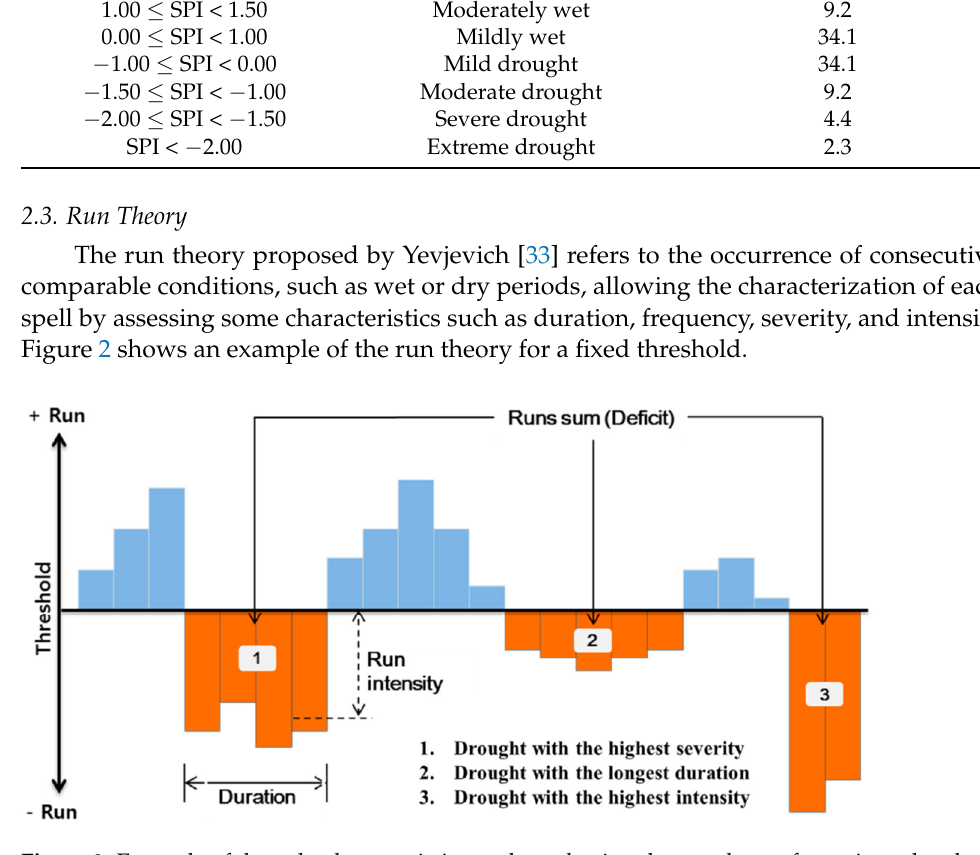
Figure 2. Example of drought characteristics evaluated using the run theory for a given threshold level [34].